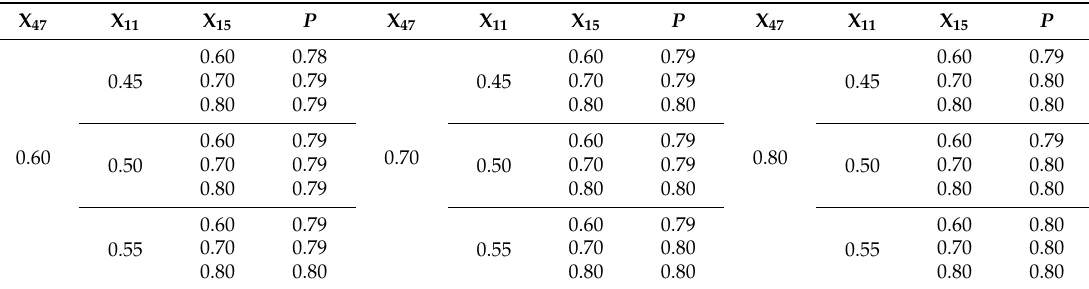
Table 7. Harmony regulation results of socio economy and RLS in